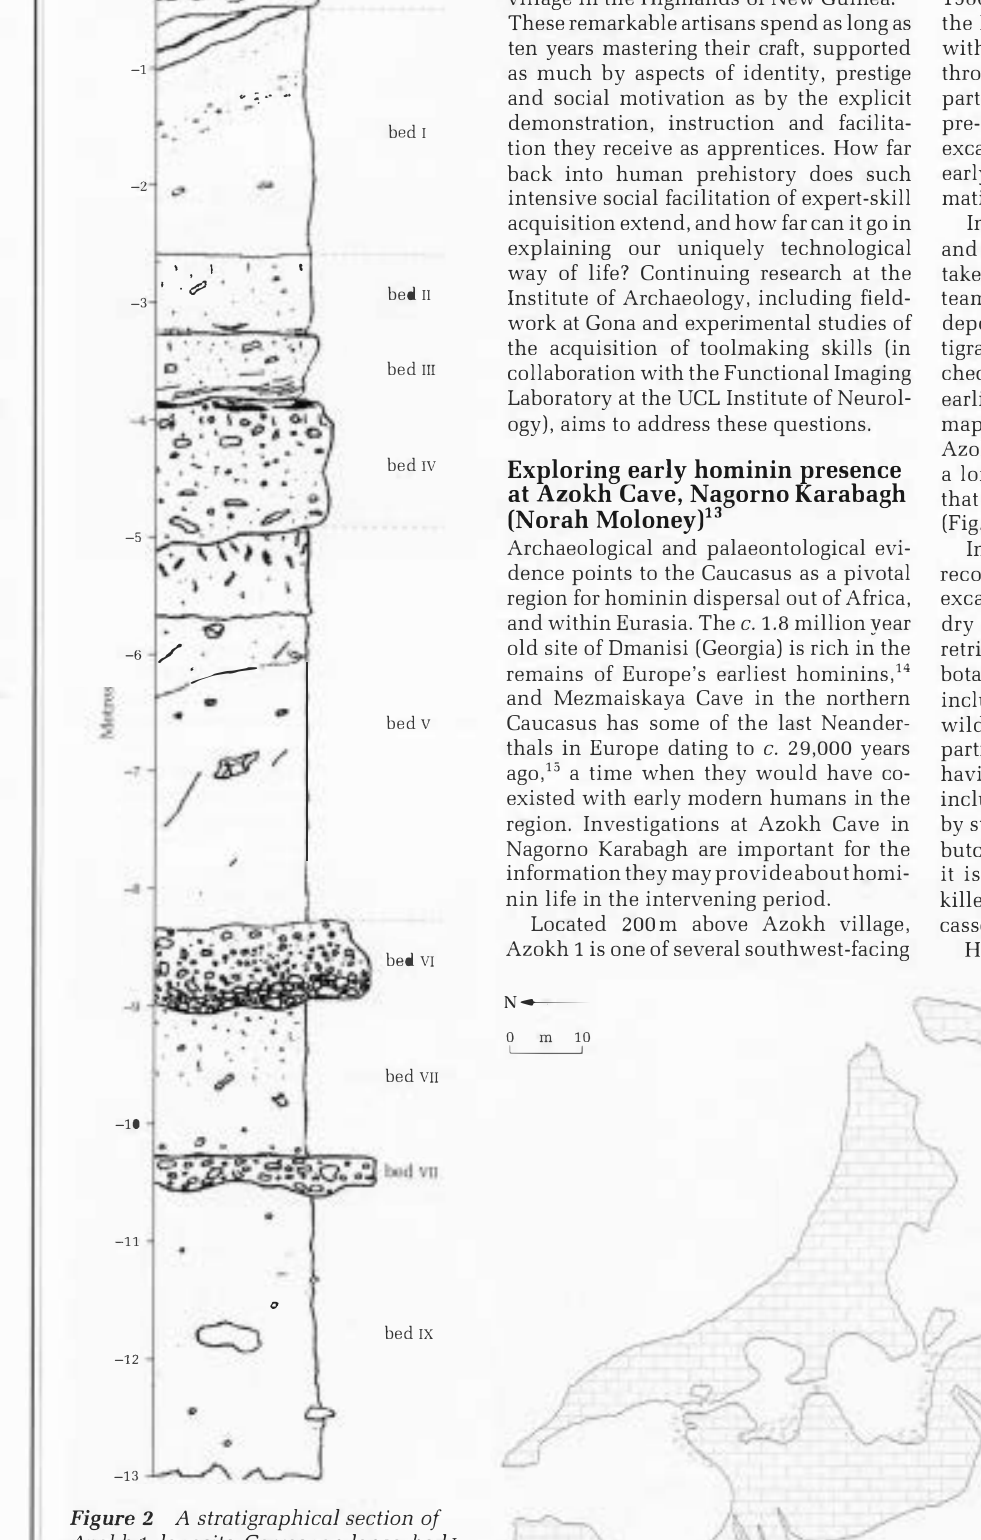
Figure 2 A stratigraphical section of Azokh 1 deposits. Correspondence: bed I­ Holocene; beds II and III- Middle Palaeo­ lithic (Mousterian); bed V -late Lower Palaeolithic (Acheulian} to early Middle Palaeolithic. Absolute dating for the sequence is in progress. (Based on a com­ Figure 3 The topography of the Azokh cave system (modified from an original by posite section drawing by Peter Ditchfield.) P. Andrews & P. Ditchfield, with